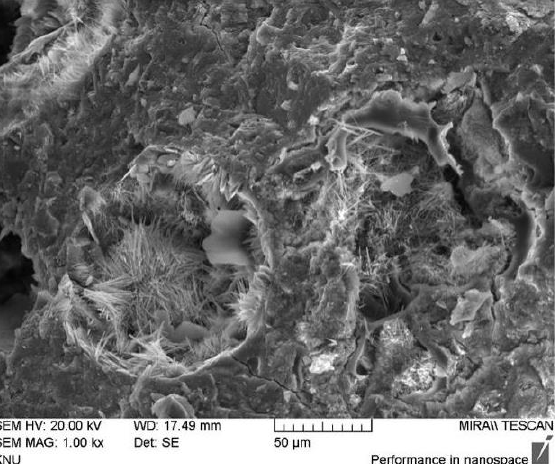
Figure 11. Needle-like products in pits. Reprint with the permission from ref.[38]. Copyright 2022 Elsevier.